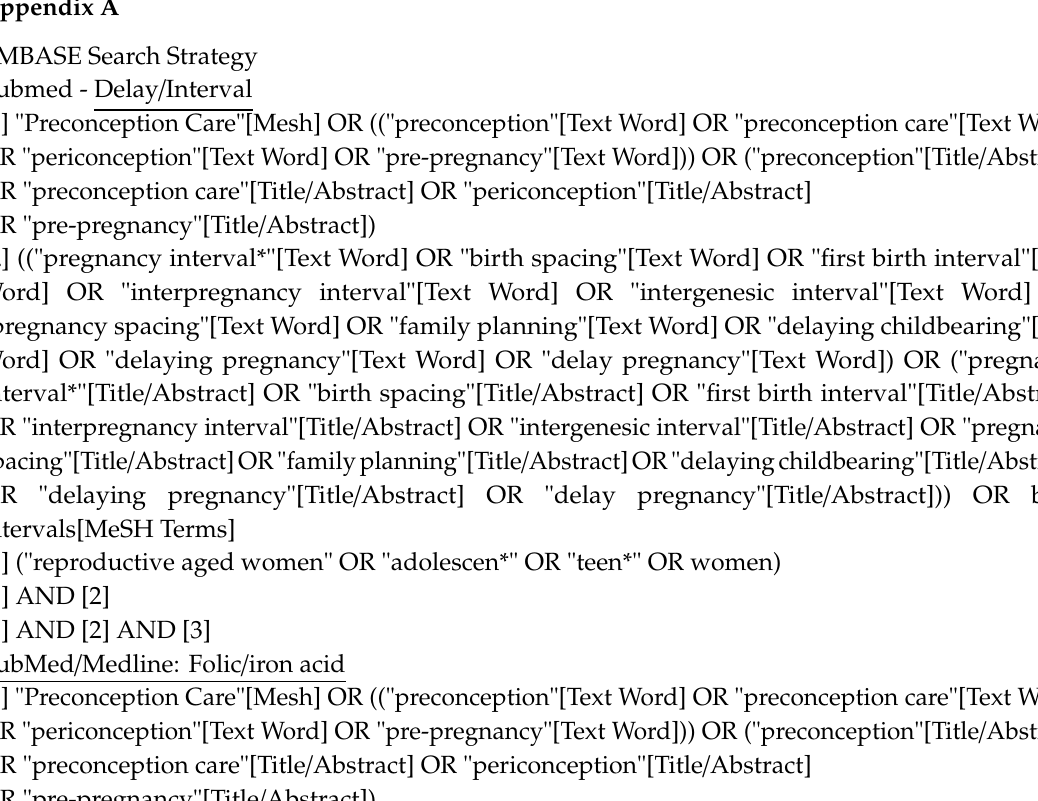
Table S1: Location the interventions were conducted by intervention